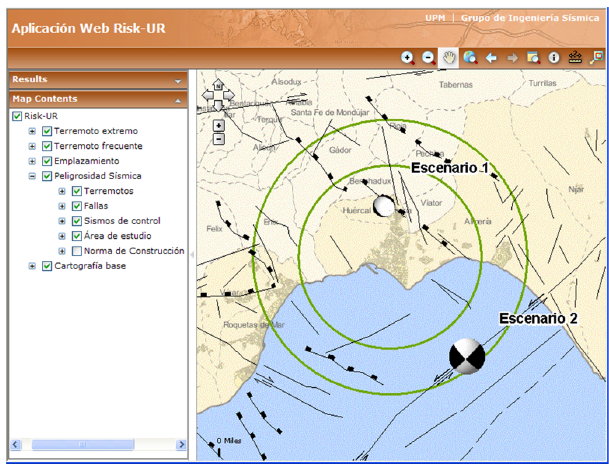
Fig. 2. Web visualiser with the two studied seismic scenarios. The location areas of the control earthquakes are indicated in